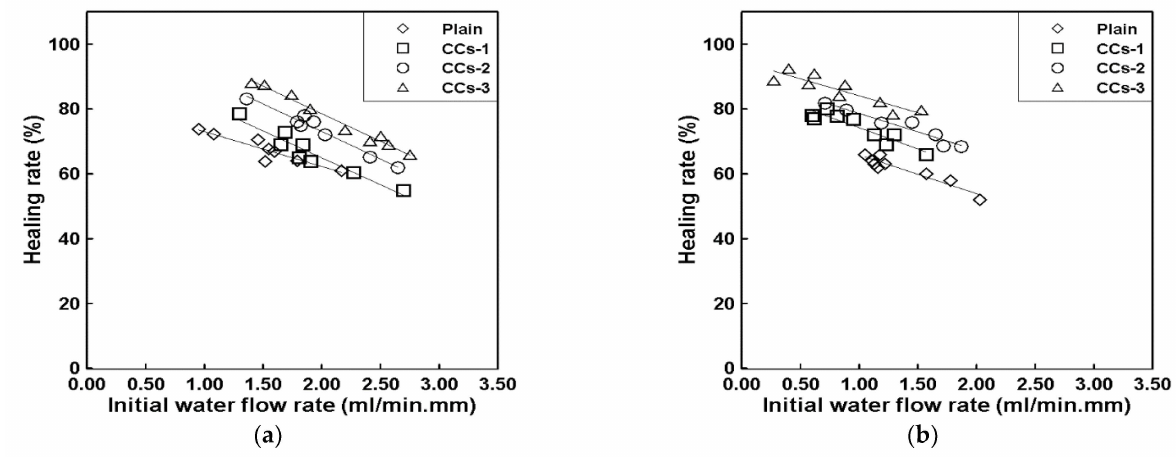
Figure 8. Correlation between the initial water flow rate and healing rate: ( a ) crack induction at 7 days; ( b ) crack induction at 28 days.